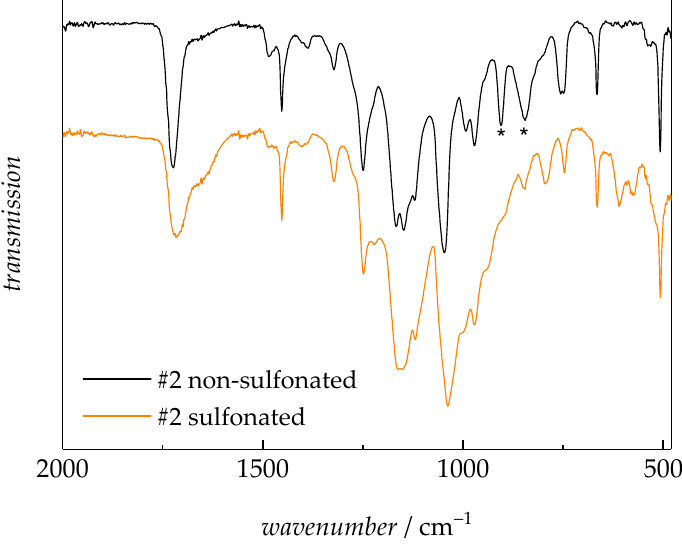
Figure 4. IR spectra for sample #2 before (black) and after (orange) sulfonation of GMA units. * mark absorptions due to the epoxy group.